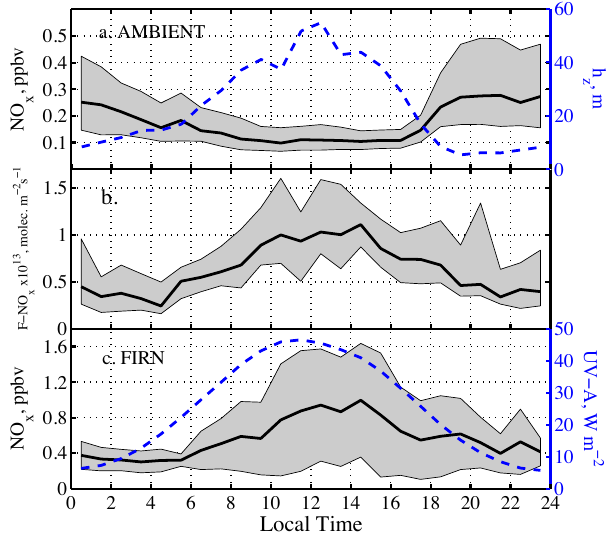
Fig. 9. The diurnal cycle of NO x atmospheric mixing ratios and flux during 22 December 2009–28 January 2010: (a) NO x mixing ratios at 1m with boundary layer height h z estimated after Pollard et al. (1973), (b) observed NO x flux (F-NO x ) between 0.01 and 1m and (c) NO x mixing ratios in firn air from occasional sampling (Table 2) and UV-A irradiance at 1m. Lines are median values and shaded areas the 25–75 percentile range of 1-hourly bins; except NO x in firn air is average ± 1 σ